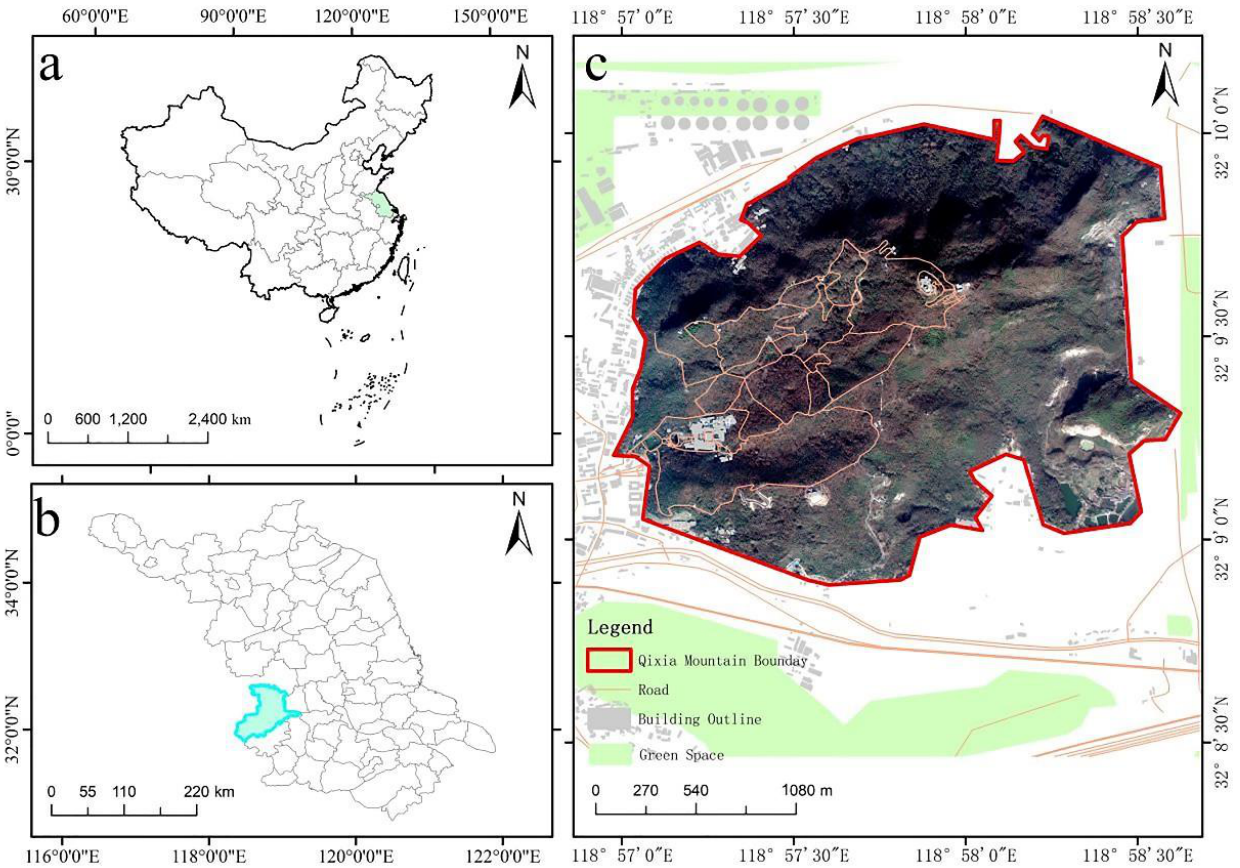
Figure 1. Geographical location of the case study area, showing the location of Nanjing ( a ) and the border of Qixia Mountain ( b , c ).